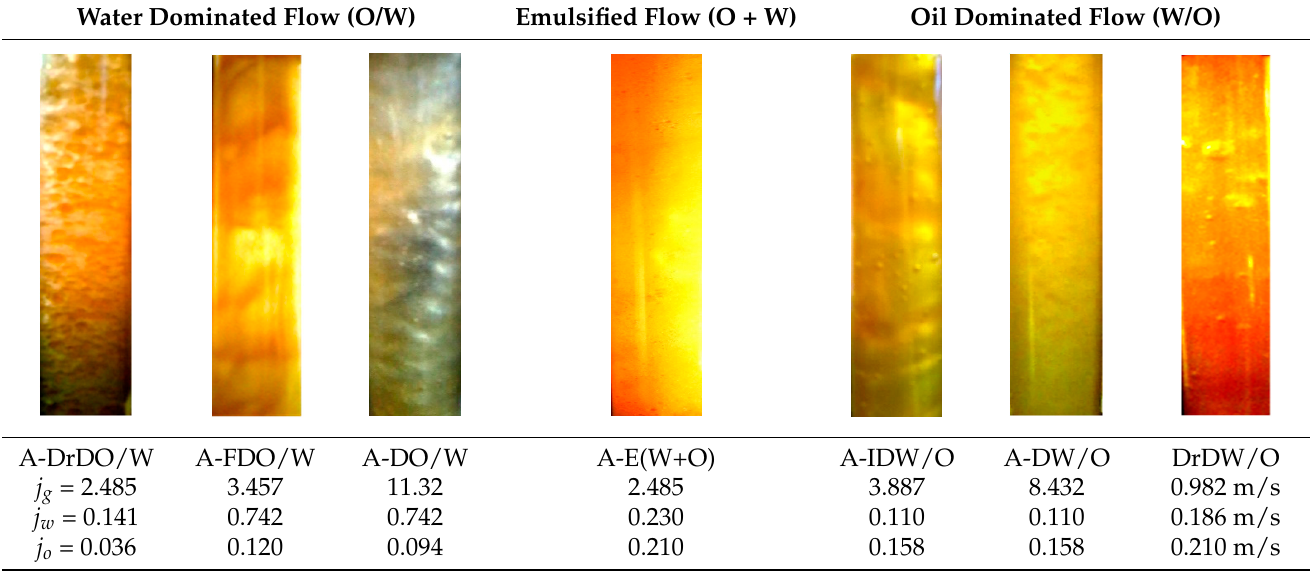
Table 4. Schematic diagrams of gas–liquid–liquid downflow patterns in vertical pipes. Water Dominated Flow (O/W)